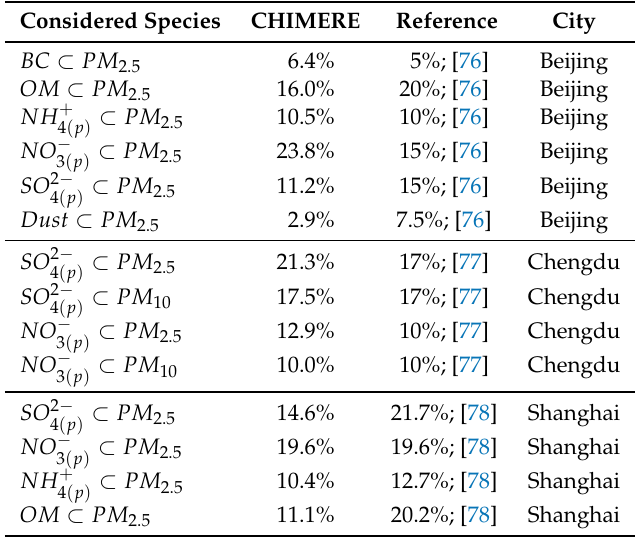
Table 5. CHIMERE contribution compared to